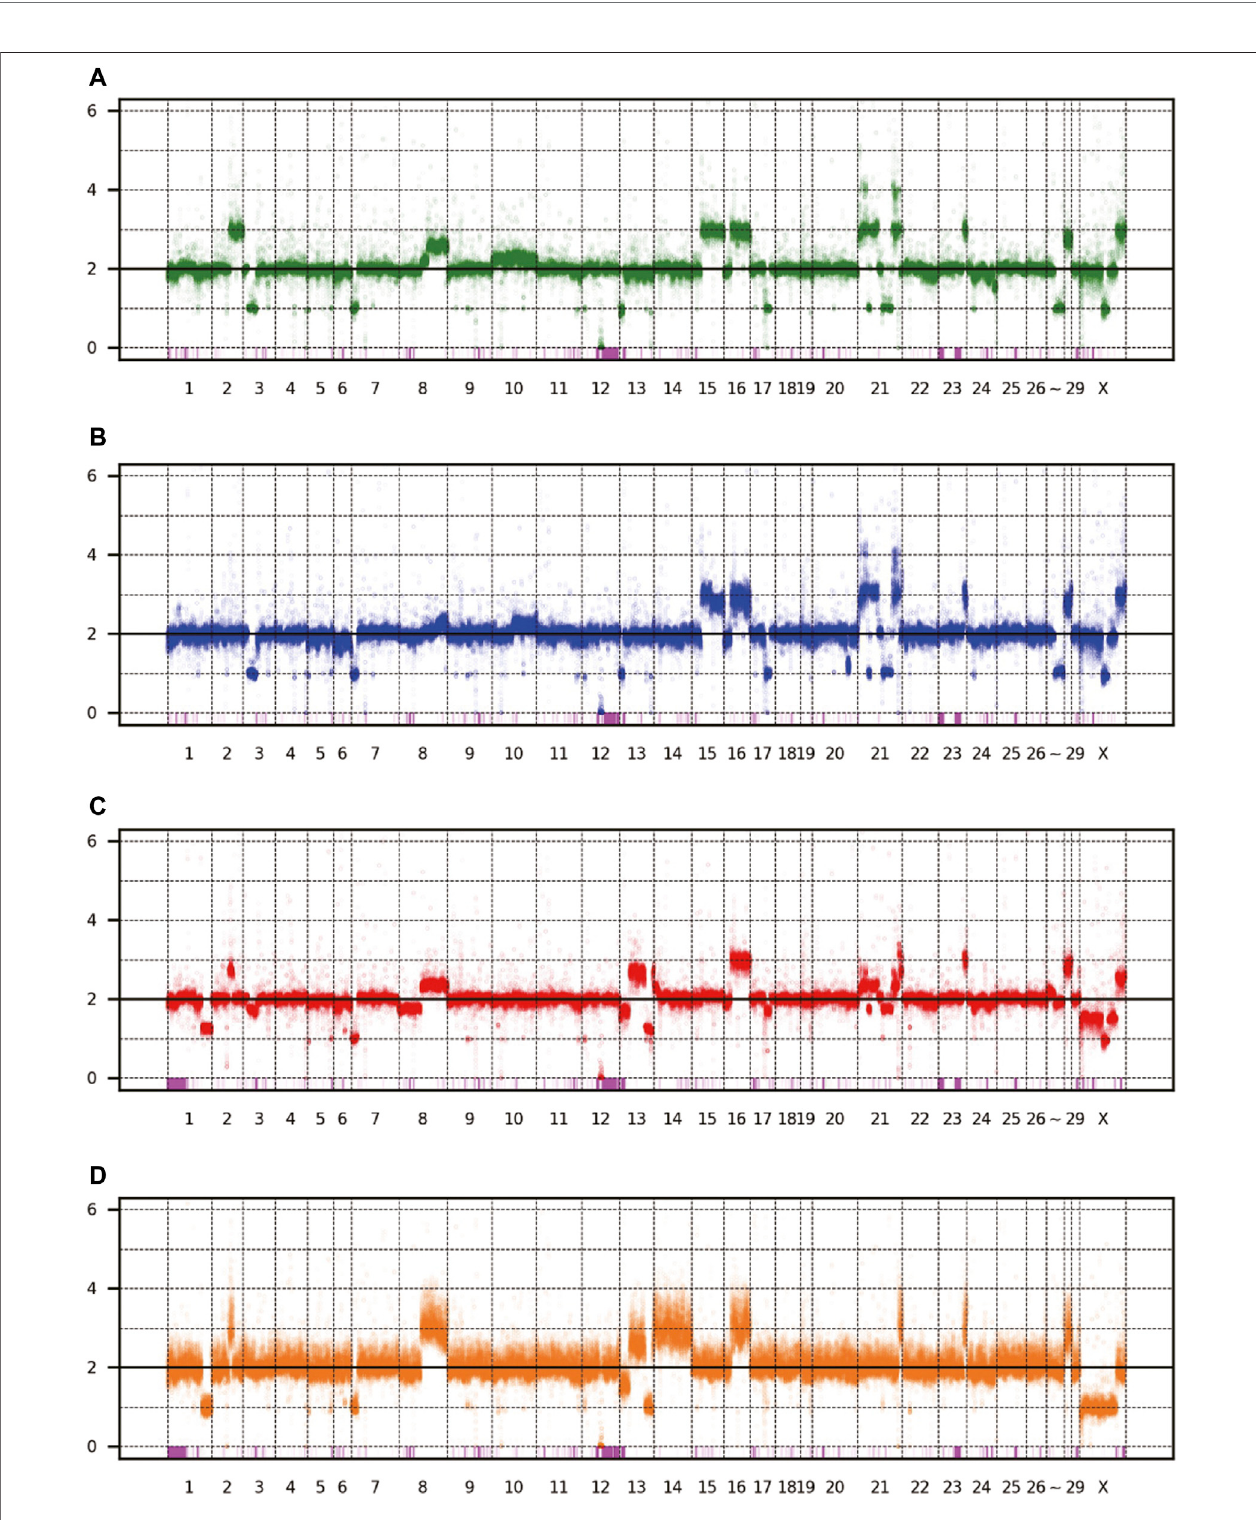
FIGURE 3 | Copy number variation of the four Vero sublines. The dots represent the estimated copy number in 50 kb-length windows. X - and y -axes denote chromosomal coordinates and estimated copy numbers, respectively. The chromosome number is labeled under the panel. The pink boxes represent the regions of LOH. (A) Vero JCRB0111, (B) Vero CCL-81, (C) Vero 76, (D) Vero E6.